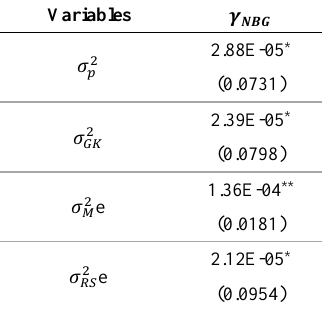
Table 4. EPU impact on NBG stock return volatility